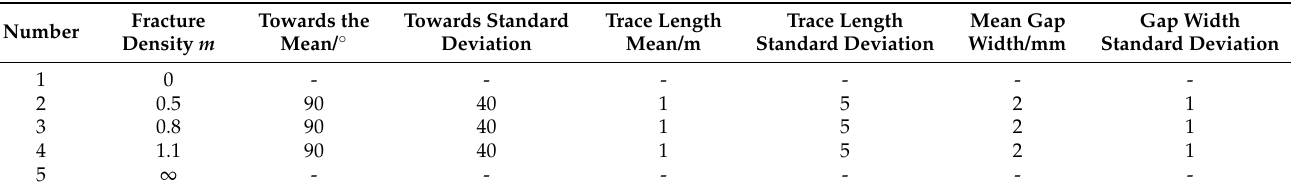
Figure 1. Images of parameters generated by f ( x , y ). ( a ) Normal function; ( b ) elastic modulus E 0 ; ( c ) elastic modulus E 1 . Table 2. Parameters of the random fracture